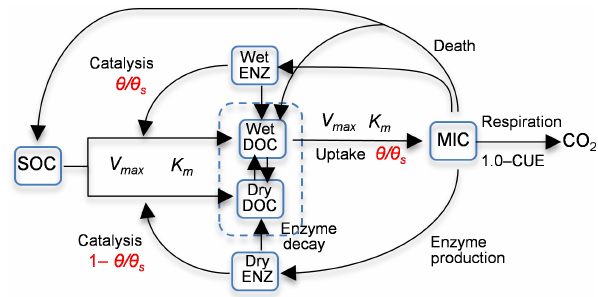
Figure 1. Diagram of model 6C representing the processes of (1) degradation of soil organic carbon (SOC) to dissolved organic carbon (DOC) through the catalysis of enzymes (ENZ) produced by microbes (MIC), (2) MIC uptake of DOC, and (3) microbial (MIC) respiration to produce CO 2 (CUE is the carbon use efficiency). SOC degradation and microbial uptake rates are controlled by water satu- ration (θ/θ s ) . The DOC and ENZ pools are split into two sub-pools, one for the wet zone and the other for the dry zone of the soil pore space. Microbial uptake of DOC only occurs in the wet zone, and the uptake rate is linearly related to θ/θ s . Catalysis through ENZ in the wet zone is proportional to θ/θ s , whereas that in the dry zone is proportional to 1 − θ/θ s . V max (s − 1 ) is the maximum rate, and K m is the half-saturation